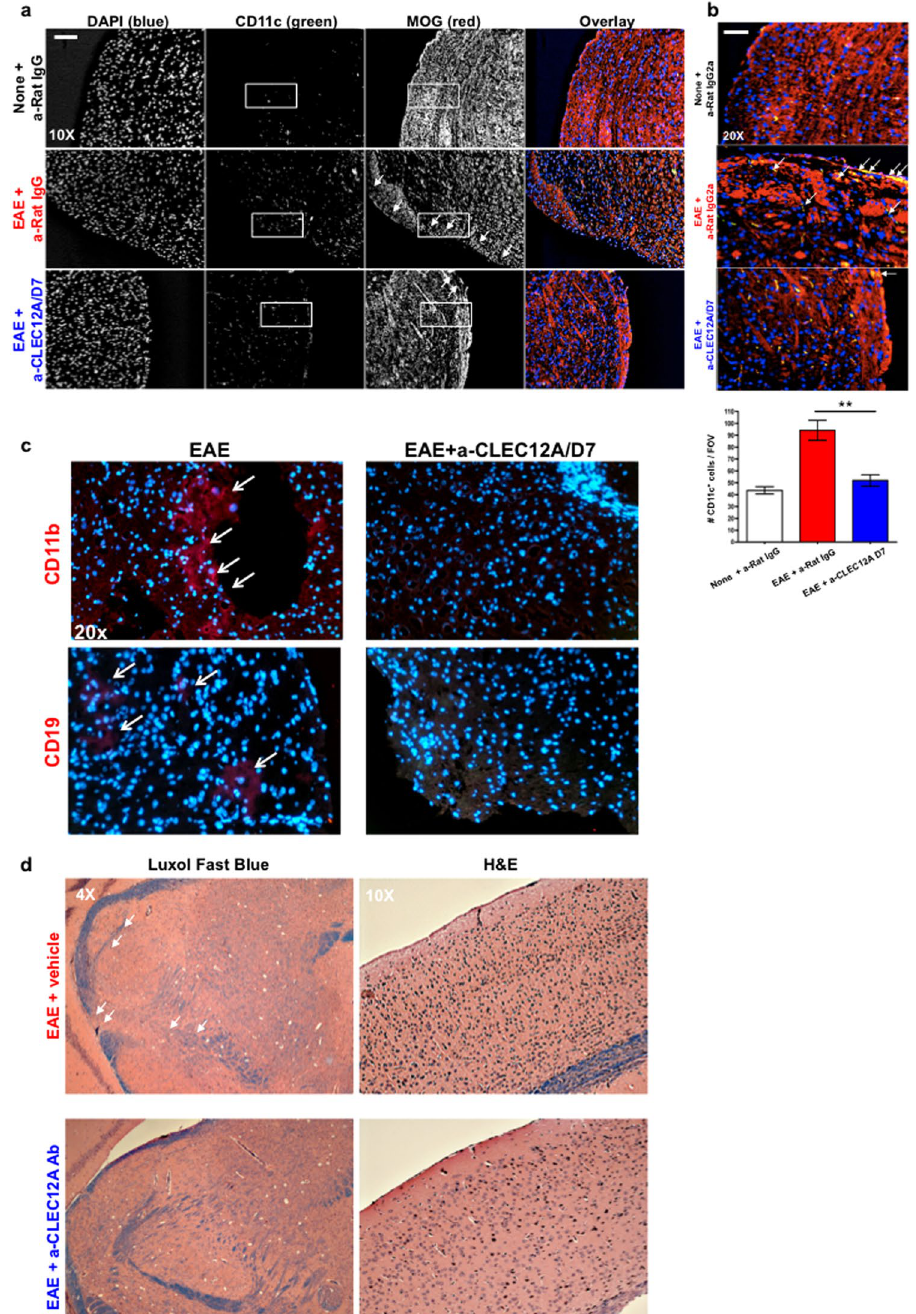
Figure 6. CLEC12A antibody treatment blocks DC infiltration within CNS tissue of EAE mice. ( a ) Spinal cord tissue from C57BL/6 mice was subjected to immunoflorescence staining with anti-CD11c (green), anti- MOG antibodies (red) and DAPI (blue). Images show demyelination (white arrows) and visual enumeration of CD11c + DCs (white box) in areas of MOG staining at 10X resolution from control, EAE and Day 7 anti- CLEC12A treated mice. Numbers represent counts from ten fields of vision from three to four sections per mouse. ( b ) CD11c + DC infiltration in areas near blood vessel of spinal cord. ( c ) Spinal cord tissue from EAE and Day 7 anti-CLEC12A treated mice C57BL/6 mice were subjected to immunoflorescence staining with anti-CD11b (Red), anti-CD19 (Green) antibodies and DAPI (blue) for myeloid cell infiltration. ( d ) LFB and H&E staining from SJL/J brain tissue depicting areas of myelinalion (blue) and cellular infiltration (black), respectively. Data presented is representative of two mice per group. For all 10x and 20x images, Scale bar: 100 μ m and for 4x images, Scale bar: 200 μ